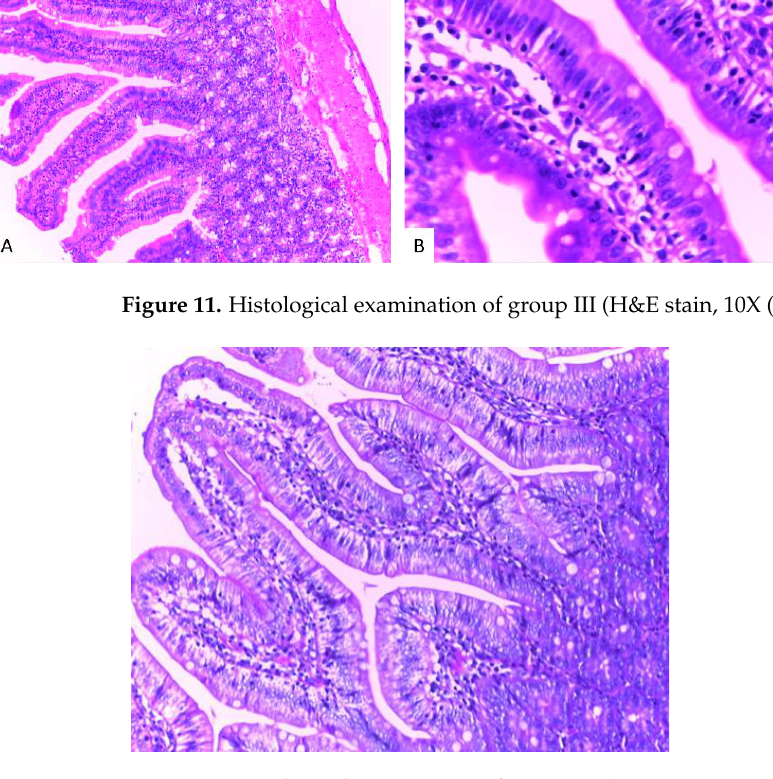
Figure 12. Histological examination of group IV (H&E stain, 20X).